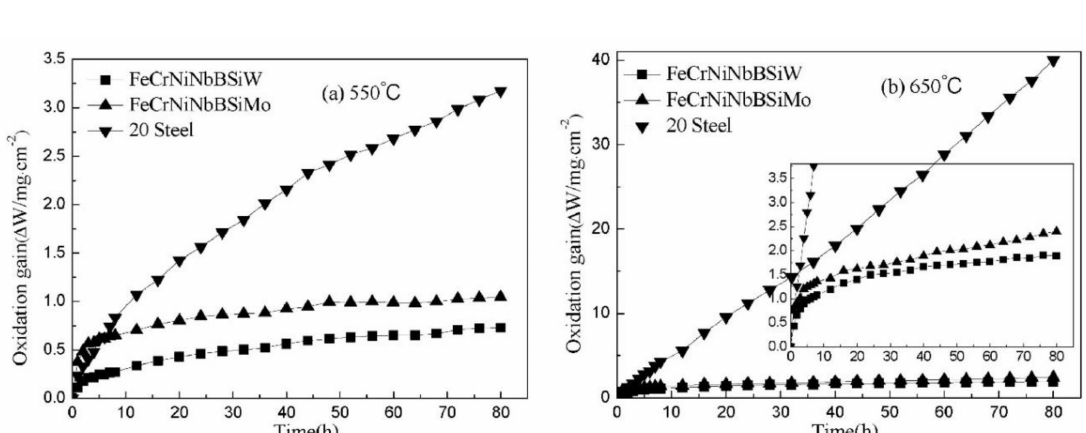
Figure 7. Oxidation kinetics curves of FeCrNiNbBSiW coating, FeCrNiNbBSiMo coating and AISI 20 steel at ( a ) 550 ◦ C and ( b ) 650 ◦ C. Reprinted with permission from ref. [28]. Copyright 2015